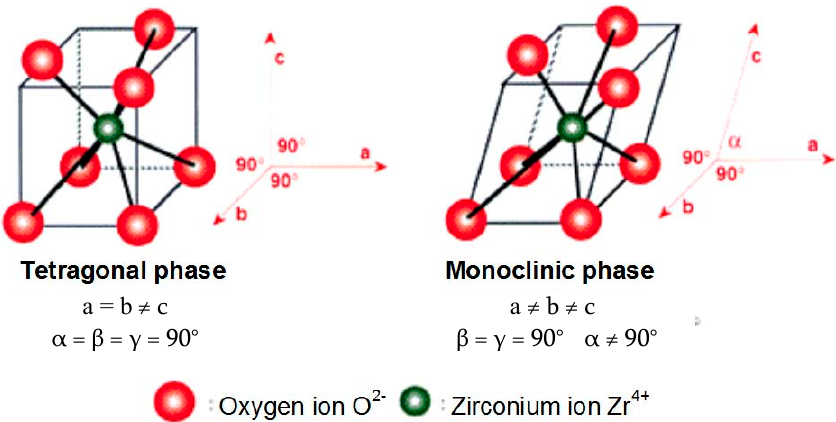
Figure 1. Tetragonal and monoclinic zirconium oxide (zirconia) structures (reconstructed by drawing with Lotus Smart Suite, Freelance Graphics IBM 2005, based on references [10,11]).